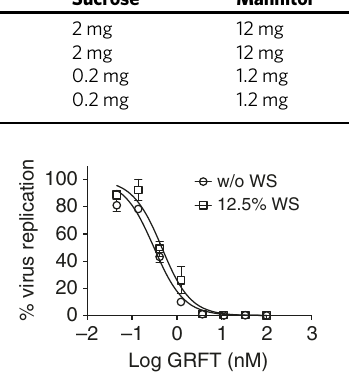
Table 1 FDI composition Species